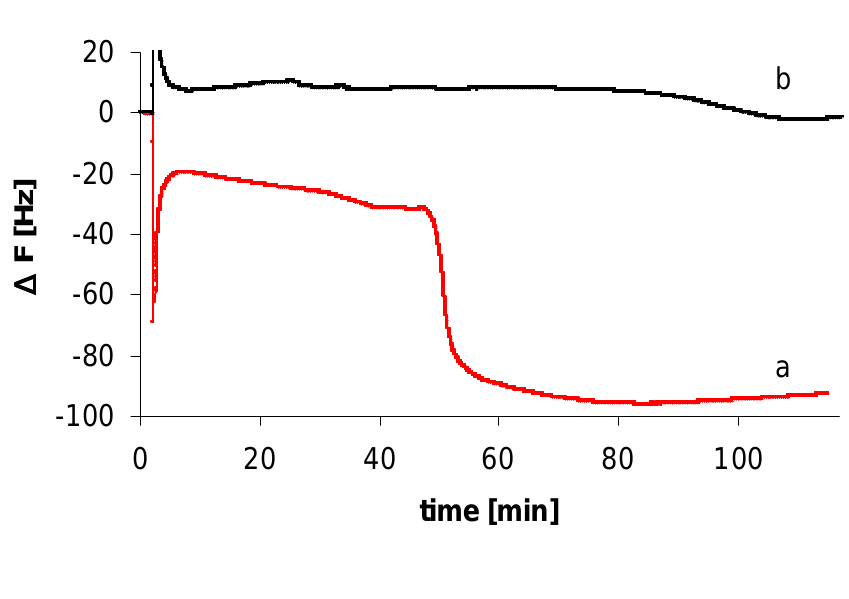
Figure 5 . Frequency response of QCM electrode modified with probe 1 via avidin-biotin system in the presence